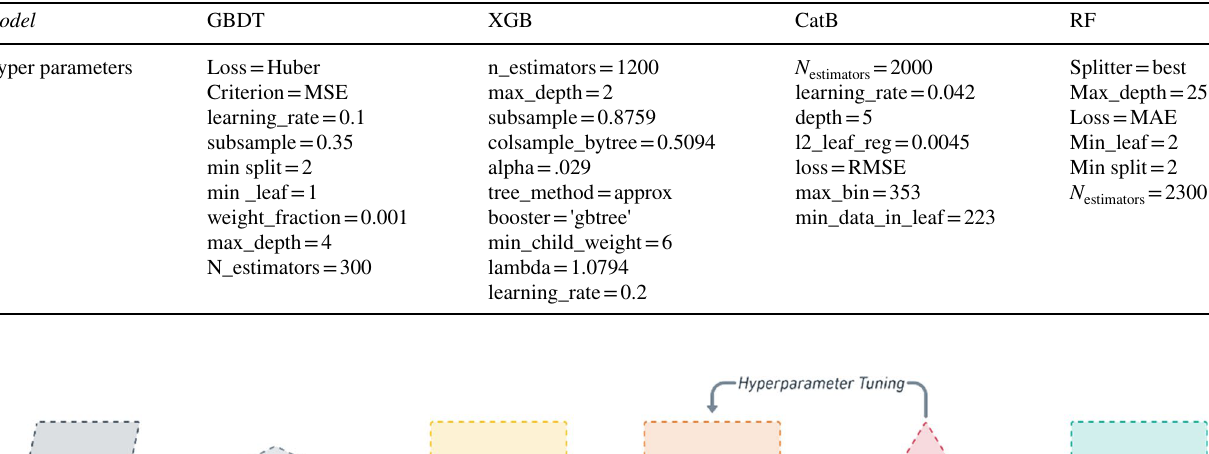
Table 3 Utilized Hyper-parameters for ensembles